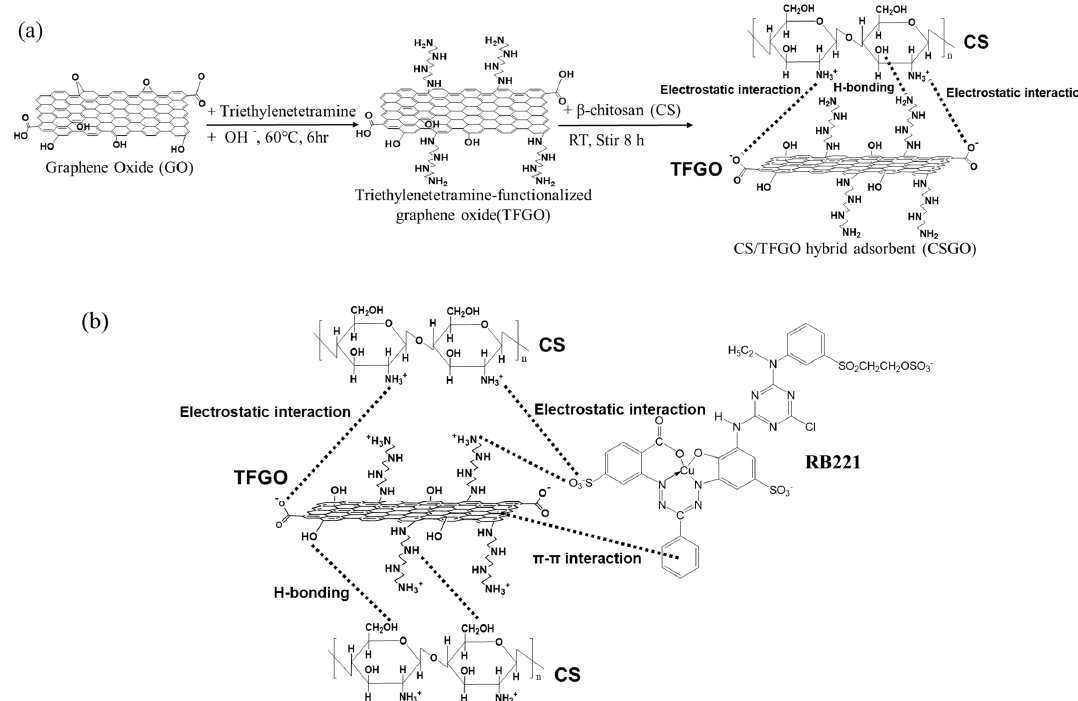
Figure 3. ( a ) Synthesis of triethylenetetramine-functionalized graphene oxide (TFGO) and the intermolecular forces between CS and TFGO during blending. ( b ) Mechanism of intermolecular forces during the adsorption of an organic dye (RB211) by the CS/TFGO hybrid adsorbent.